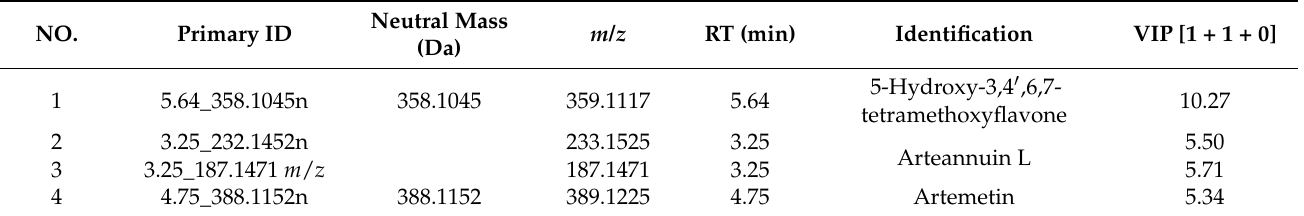
Figure 5. OPLS-DA of 2% ALE-NA and 2% AHE-NA. ( A ) Score plot in positive-ion mode. ( B ) S-plot in positive-ion mode. ( C ) Score plot in negative-ion mode. ( D ) S-plot in negative-ion mode. Red dots represent VIP > 5 data. ( n = 3). Table 6. The differential chemical compositions positively correlated with antimalarial activity between 2% ALE-NA and 2% AHE-NA.